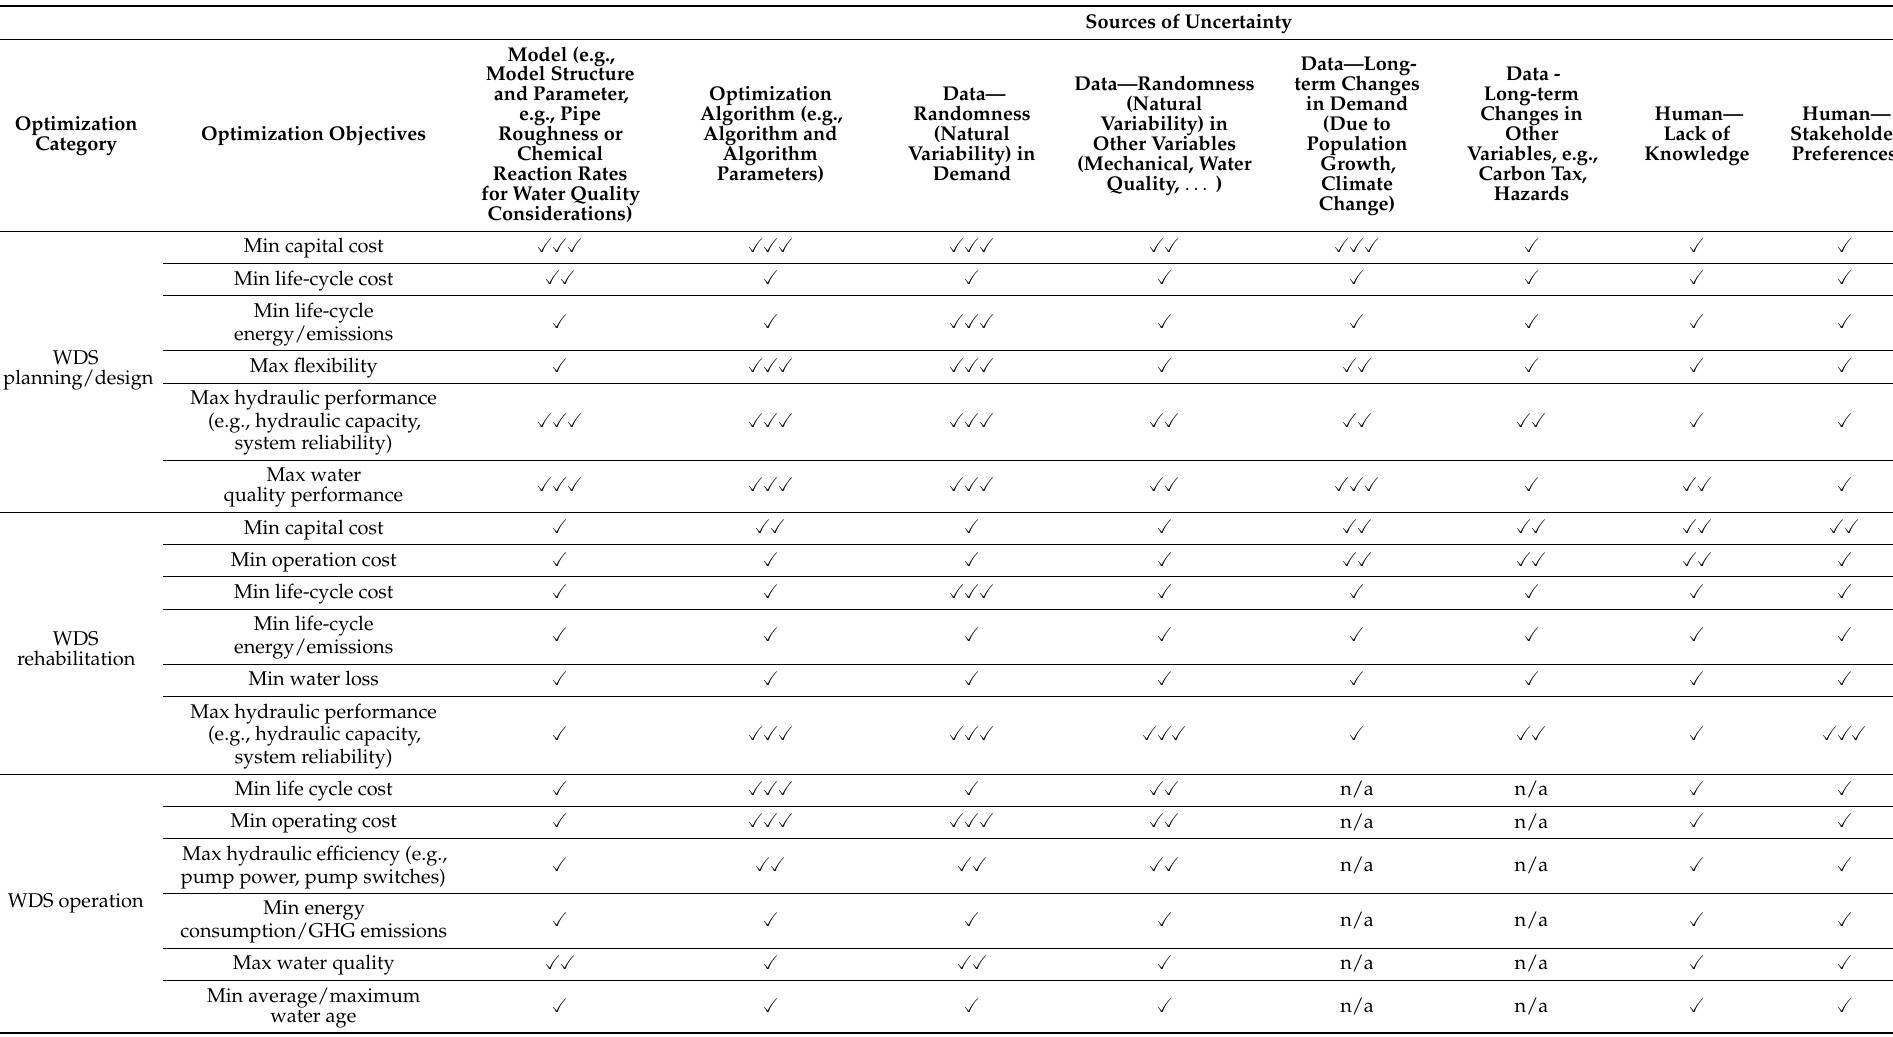
Table 2. Summary of the Extent to which each Source of Uncertainty in Relation to each Objective is Investigated in Previous Literature (three ticks